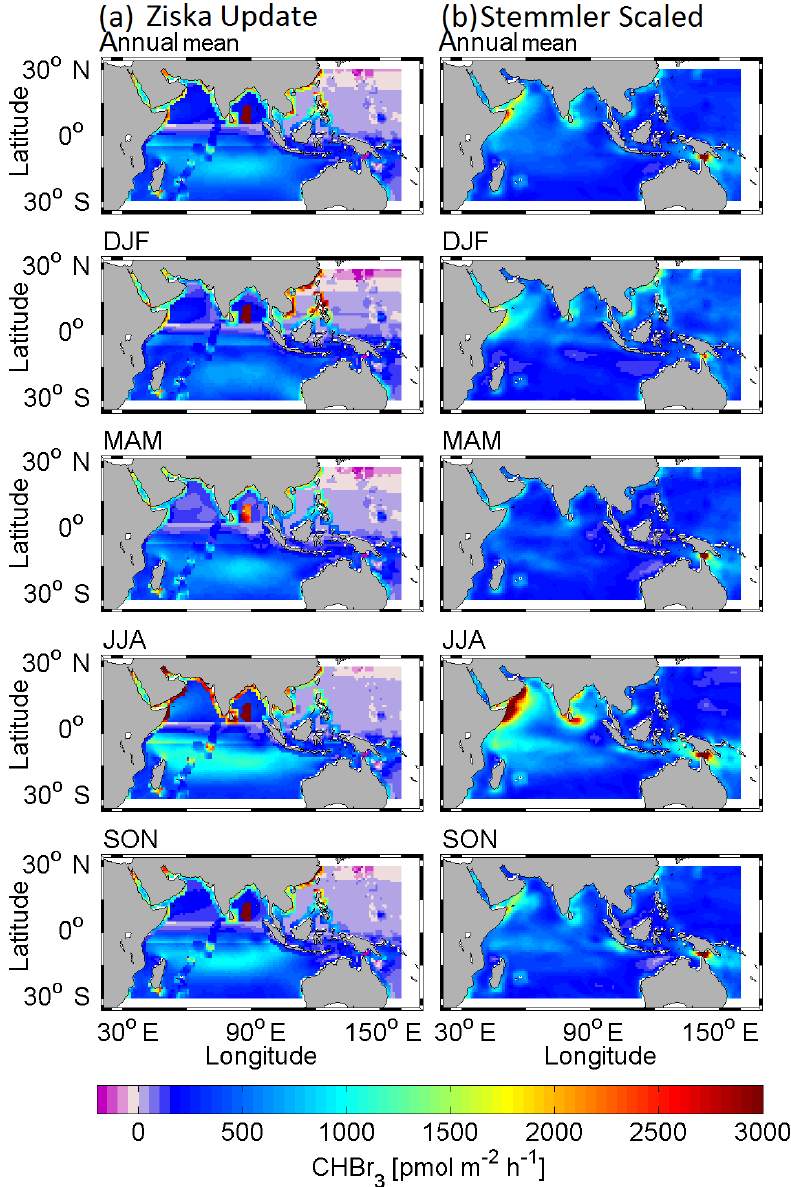
Figure 2. Annual and seasonal mean bromoform emissions from the Indian Ocean and west Pacific release area (30 ◦ N–30 ◦ S, 30–160 ◦ E) of the inventories Ziska Updated (a) and Stemmler Scaled (b)